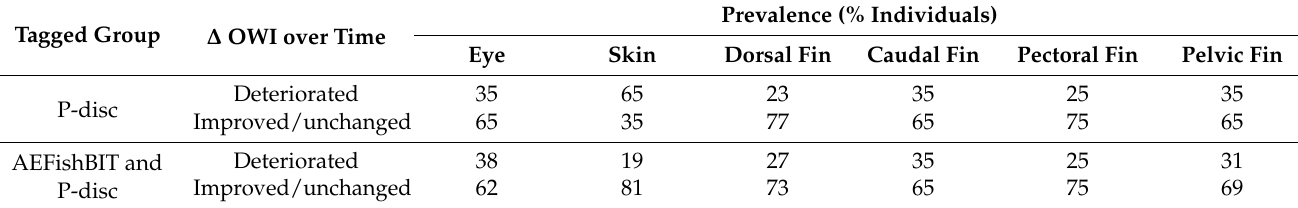
Table 3. Change in the severity of damage of evaluated operational welfare indicators prior to start and the end of the experiment. The numbers in the table represent percentages of fish with either worsened or improved/unchanged severity of damage (score between 0 and